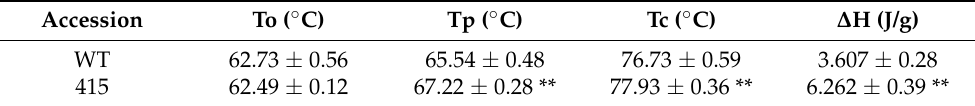
Table 2. Analysis of the thermal properties of starch in the WT and M3-415 lines.